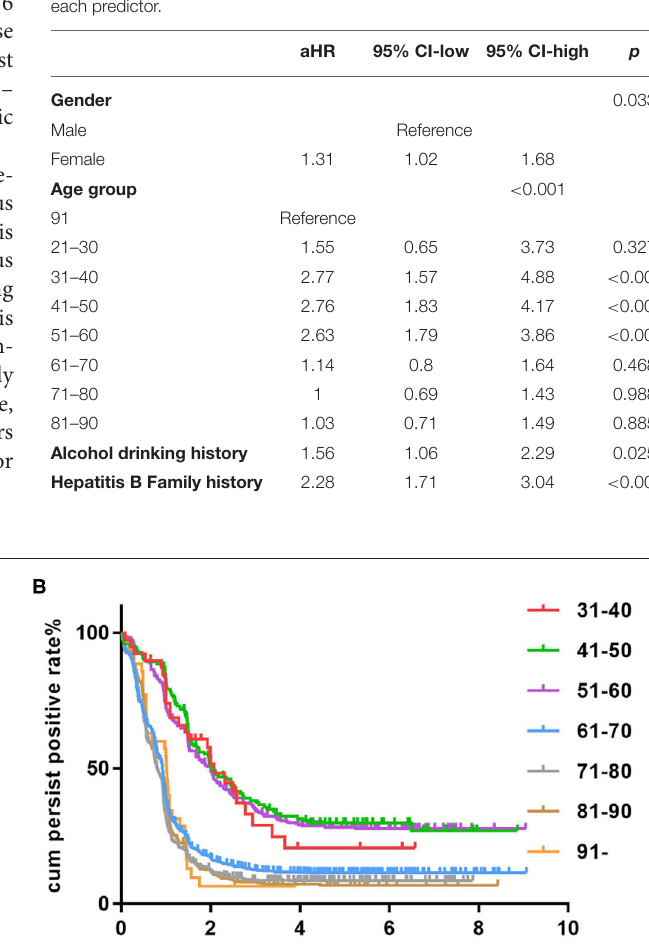
TABLE 3 | Multi-variate analysis of HBsAg persist positive rate with 95% CI for each predictor.